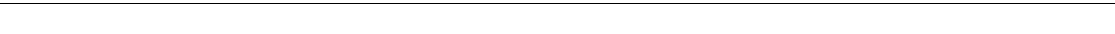
Figure 1. Conceptual Framework Showing Relationship of Small and Minority Farmers’ Social Networks and Farm